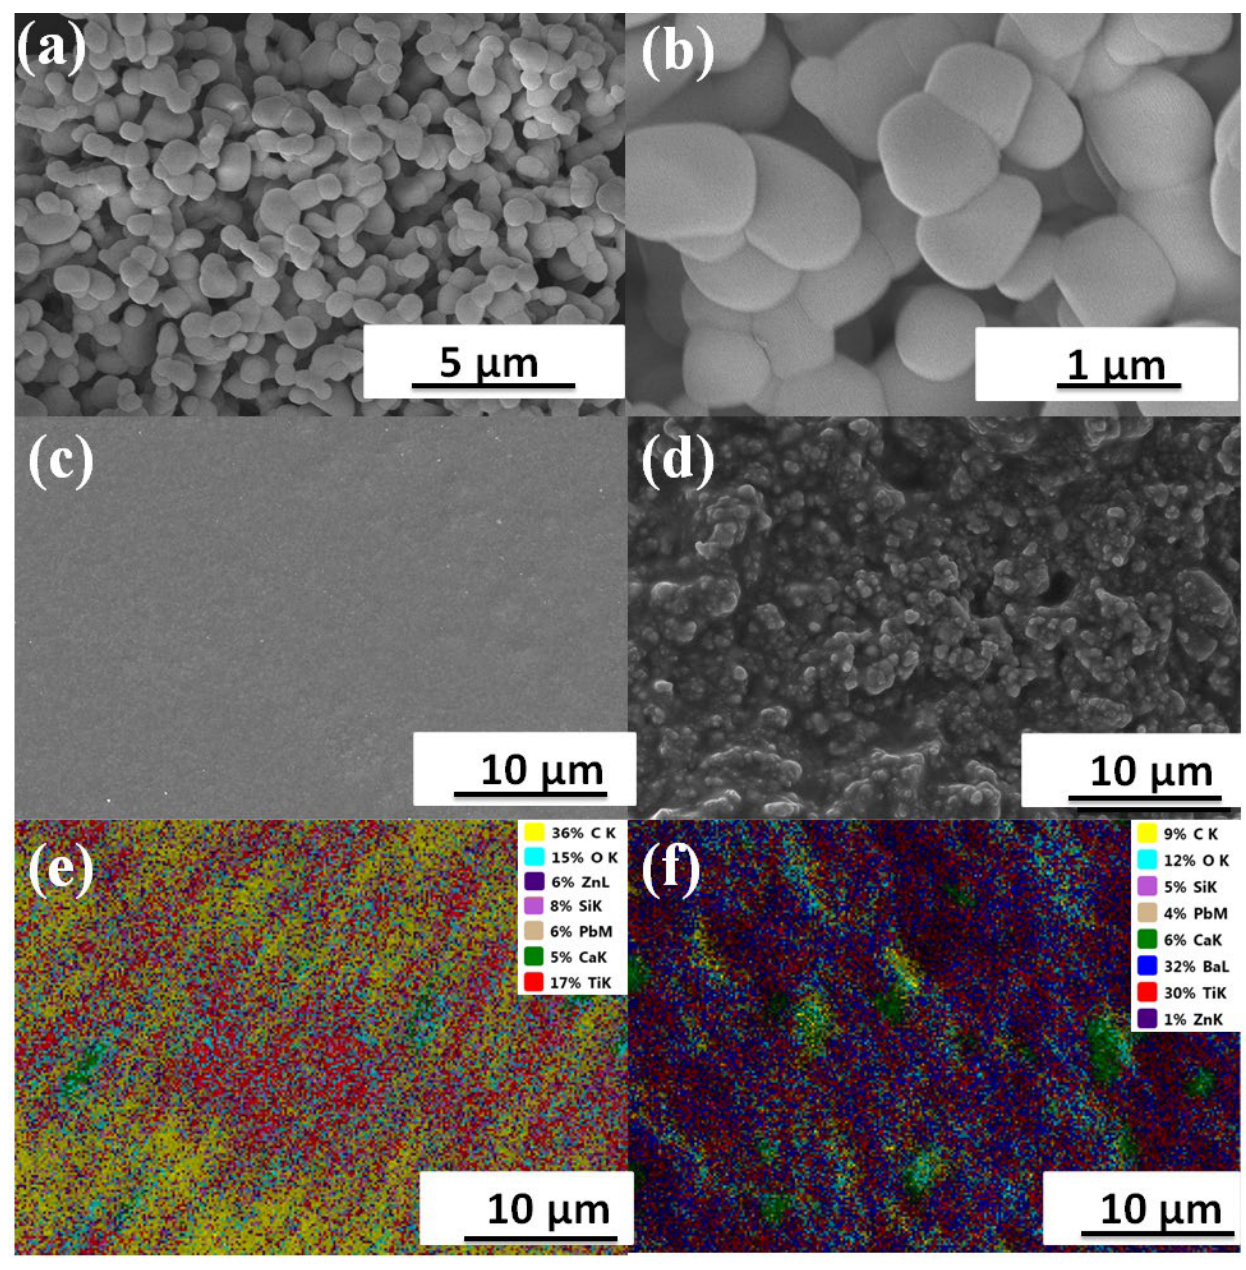
Figure 3. ( a , b ) SEM images of BT, ( c ) polymer paint, and ( d ) BT-polymer composite. ( e ) Element mapping of polymer paint, and ( f ) BT-polymer composite.